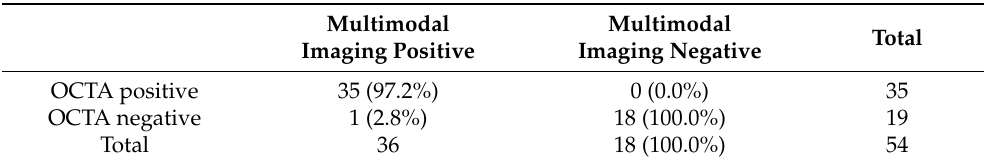
Table 1. Comparison of the multimodal imaging techniques and OCTA for the diagnostic accuracy of macular neovascularization.